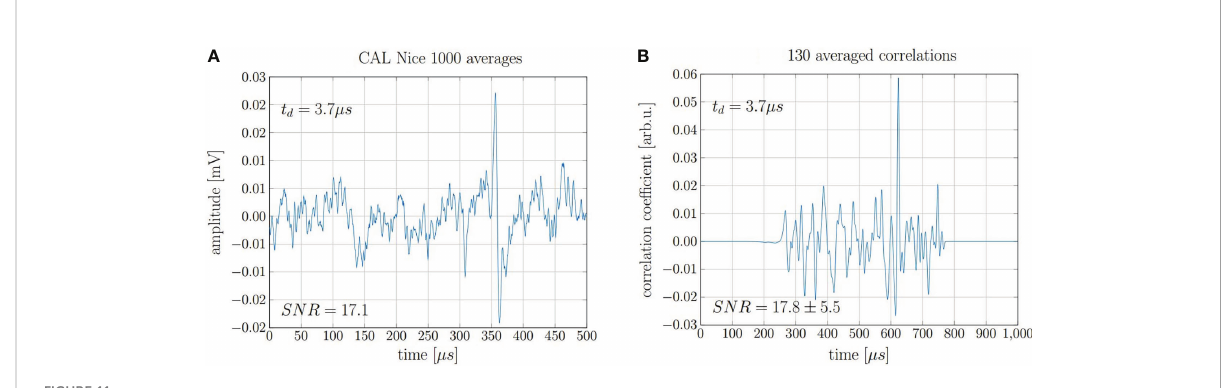
FIGURE 11 (A) 1000 averaged signals depositing 0.01 Gy maximum dose each and (B) 130 averaged correlations of individual